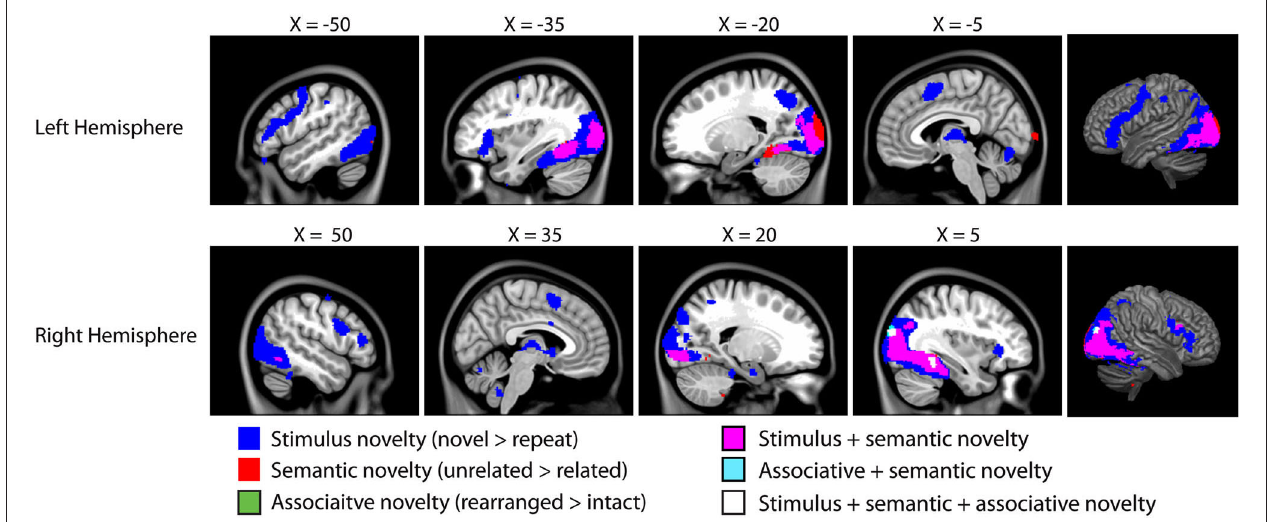
legend). All clusters are significant at p < 0.05 corrected for cluster extent (48 voxels) at t = 3.64 (corresponding to p < 0.001 uncorrected). All coordinates in MNI space, images overlaid on the MNI152 template.